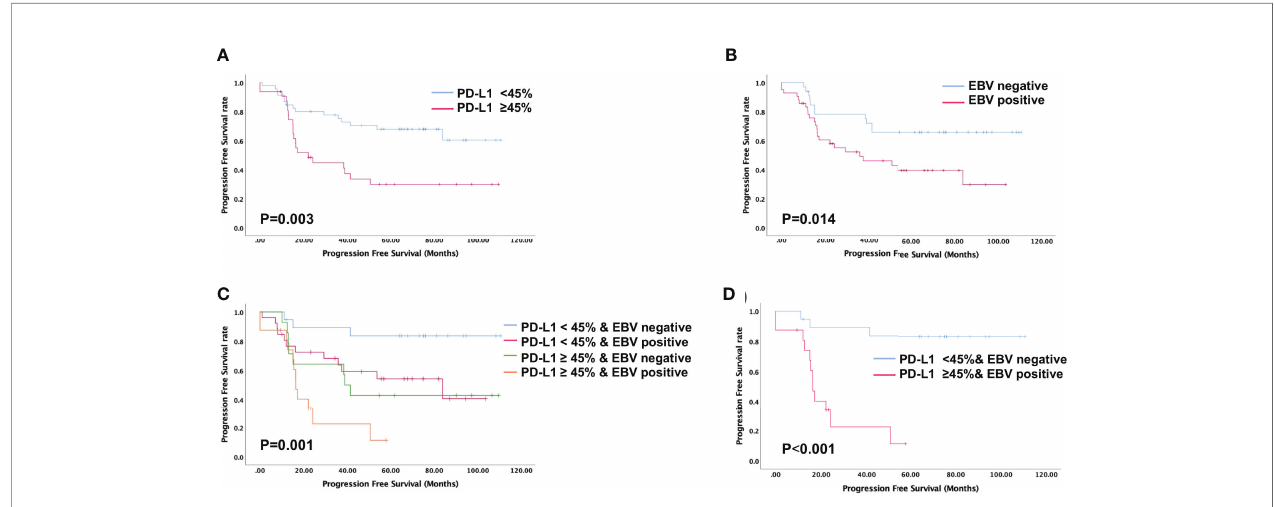
FIGURE 3 | Evaluation of progression-free survival using the Kaplan-Meier survival analysis. (A) Patients with high PD-L1 expression is associated with shorter progression-free survival; (B) Patients with positive EBV status is associated with shorter progression-free survival; (C, D) Progression-free survival based on both PD-L1 expression levels and EBV status indicated that patients with high PD-L1 expression and positive EBV status is associated with shortest progression-free survival.